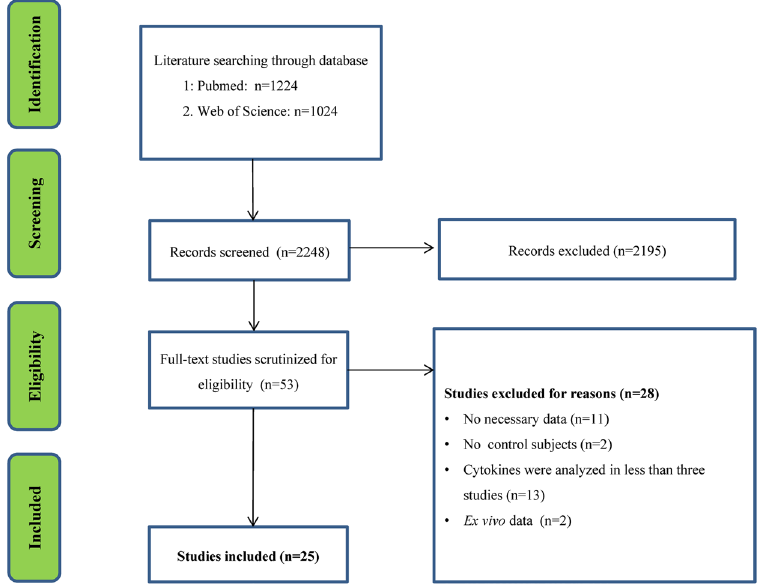
Figure 1. PRISMA flowchart of the literature